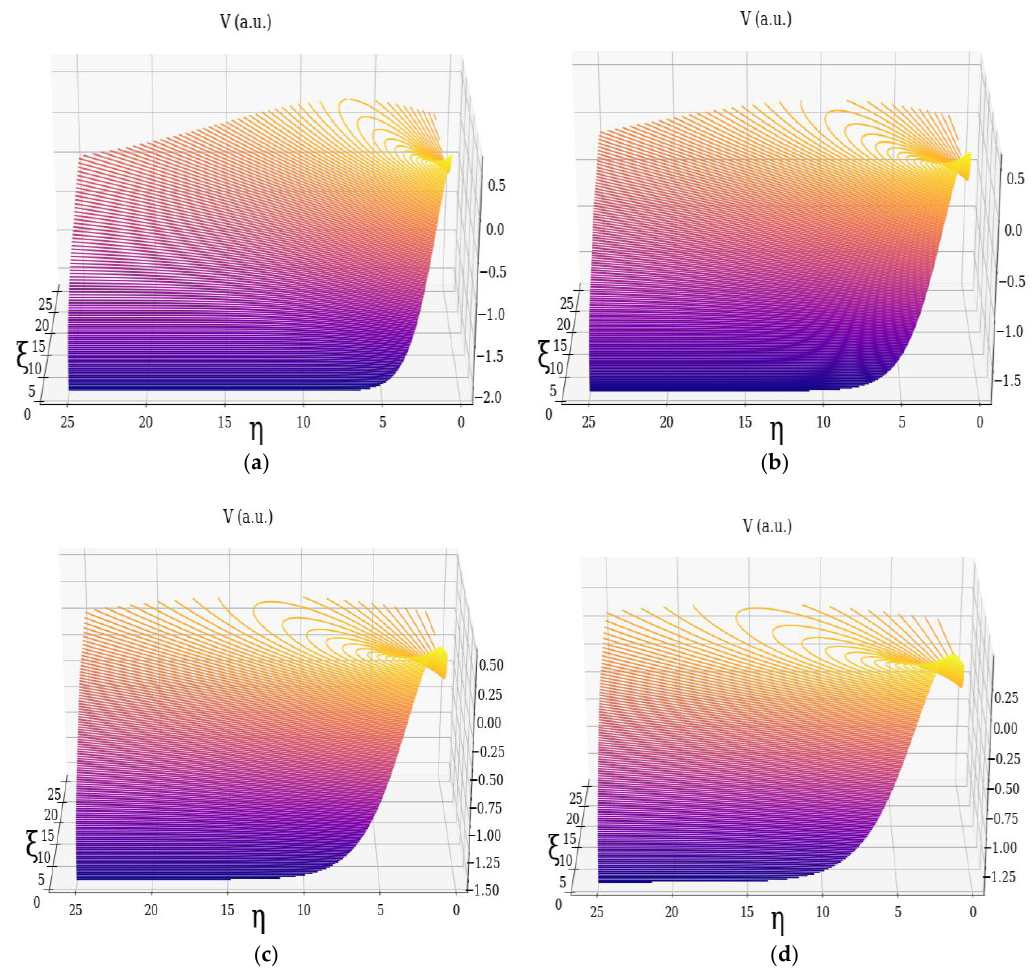
Figure 2. Dimensionless velocity field V of non-differentiable atmospheric multifractal: ( a ) ν = 0.5 , ( b ) ν = 1 , ( c ) ν = 1.5 , ( d ) ν = 2 .